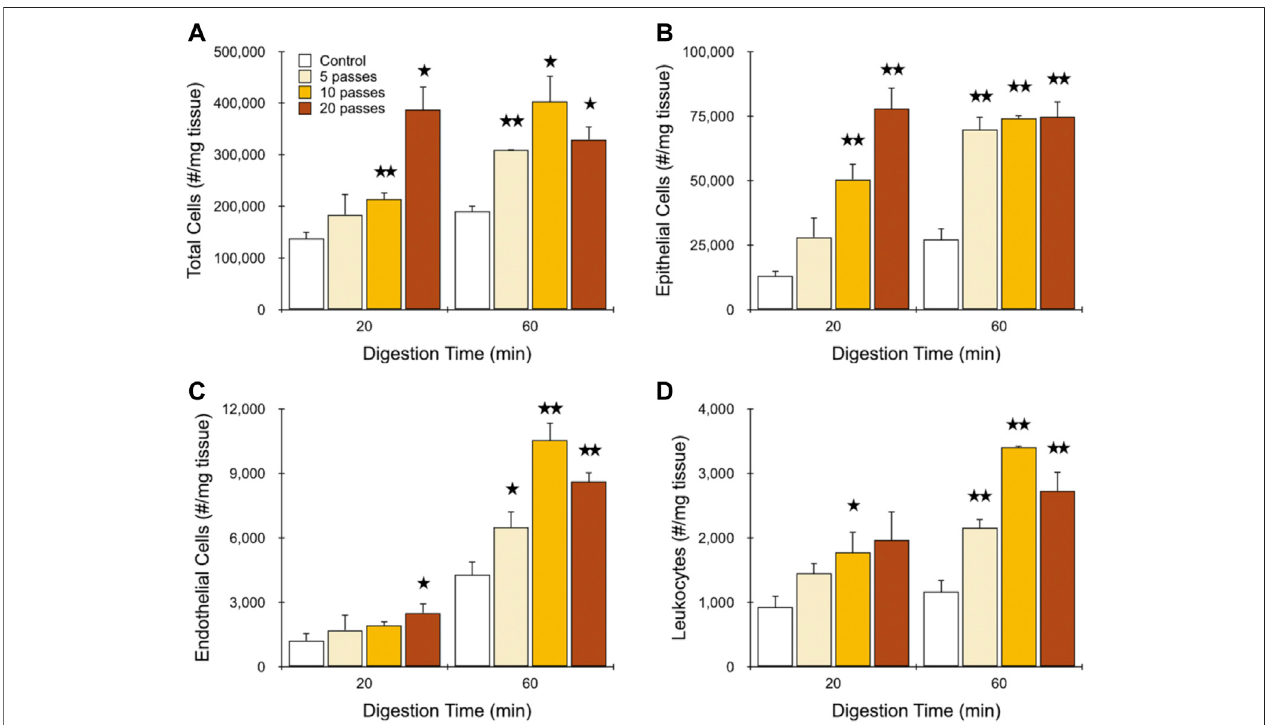
FIGURE5 | Final optimization ofmurinekidney.Kidneys wereharvested, minced, and digestedfor the indicatedtimeperiods. Sampleswerethen passed through thechannelmodulefortheindicatednumberoftimesand fi ltermoduleonce(10C,1F)andresultingcellsuspensionswereanalyzedusing fl owcytometry. Controlswere pipetted/vortexed and passed through a cell strainer. Results are shown for viable and single (A) total cells, (B) EpCAM + epithelial cells, (C) endothelial cells, and (D) leukocytes. Similar epithelial yields were obtained after 20 min digestion time using 20 passes and 60 min digestion time using 10 passes. However, maximal endothelialand leukocyte yields required 60 mindigestiontime and 10 passes. Dataarepresentedasmean values ±SEMfrom at least three independent experiments. Two-sided t test was used for statistical testing. Stars indicate p < .05 and double stars indicate p < .01 relative to the control at the same digestion